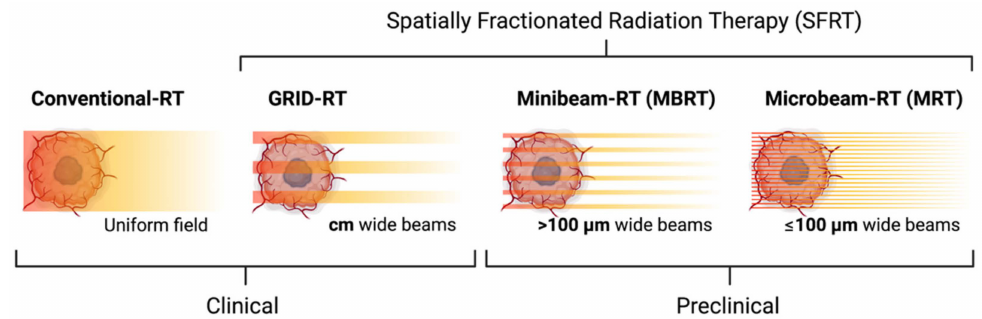
Figure 1. Illustration of radiation spatial distribution of SFRT. Starting from conventional RT where radiation is seamless, SFRT radiation is spatially fractionated in increasing smaller scales—from clinical GRID-RT (and lattice therapy not shown) to preclinical MBRT to